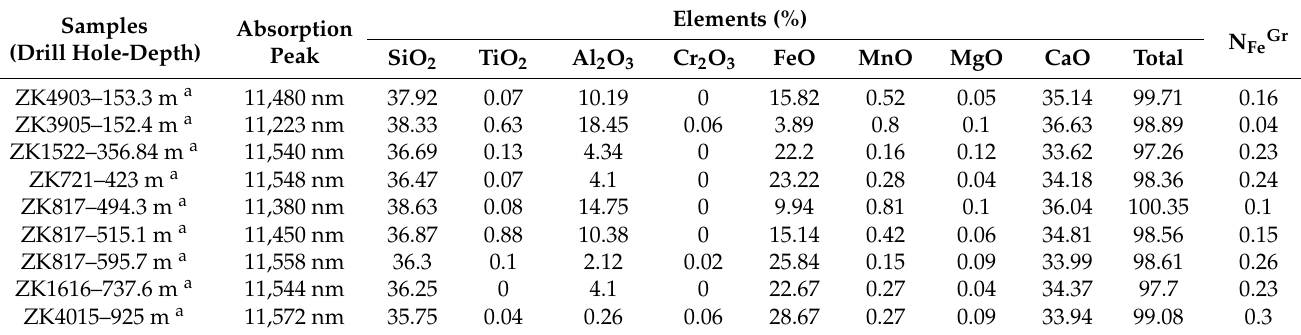
Table 4. EPMA analysis results (wt. %) and N FeGr of garnet.